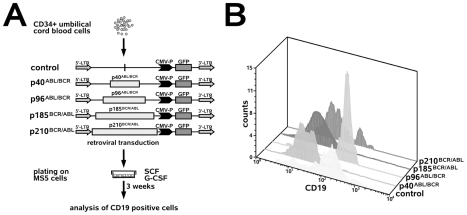
Differential effects of p40ABL/BCR, p96ABL/BCR, p185BCR/ABL and p210BCR/ABL on the B cell commitment of human HSC.(A) Experimental strategy for studying the influence of the reciprocal t(9;22) fusion proteins on the B cell commitment of human CD34+ UCBCs. CD34+ UCBCs were infected with the indicated retroviruses and plated on MS5 cells in the presence of SCF and G-CSF. After three weeks, the percentage of CD19+ cells was determined. (B) Histograms representing CD19+ cells in the GFP-positive cell population. The experiments were performed twice with similar results.